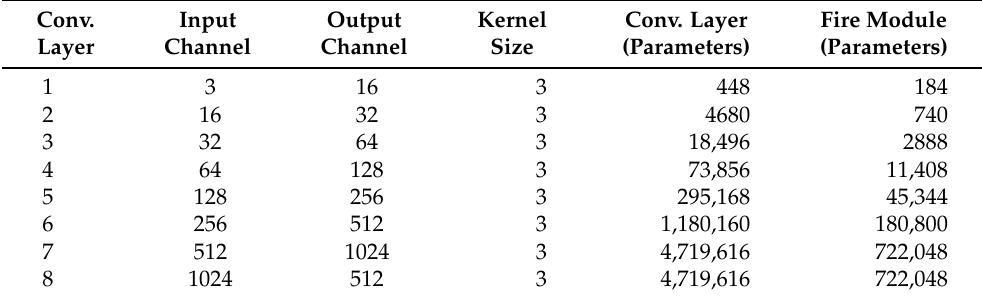
Table 6. Parameter numbers comparison between fire modules and convolutional layers.